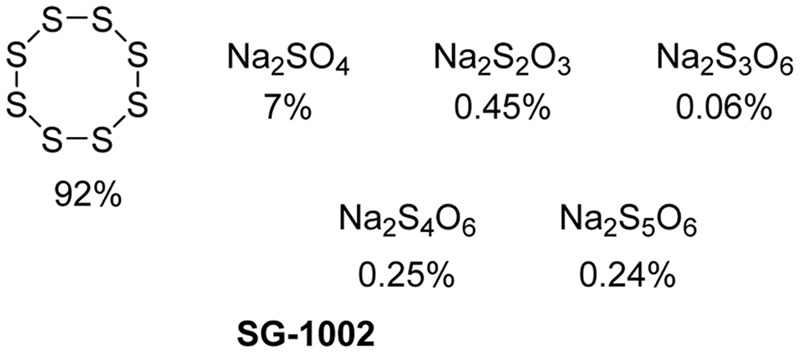
SG-1002 Components.